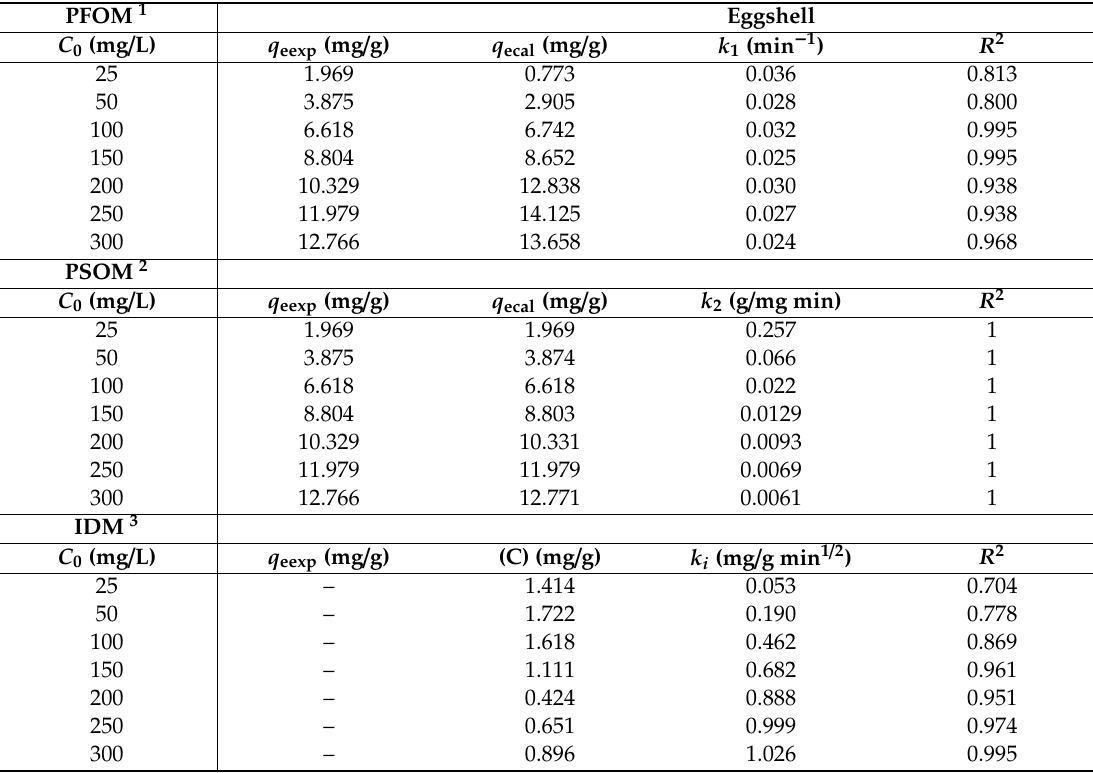
1 PFOM: pseudo-first-order model; 2 PSOM: pseudo-second-order model; 3 IDM: intraparticle diffusion model.